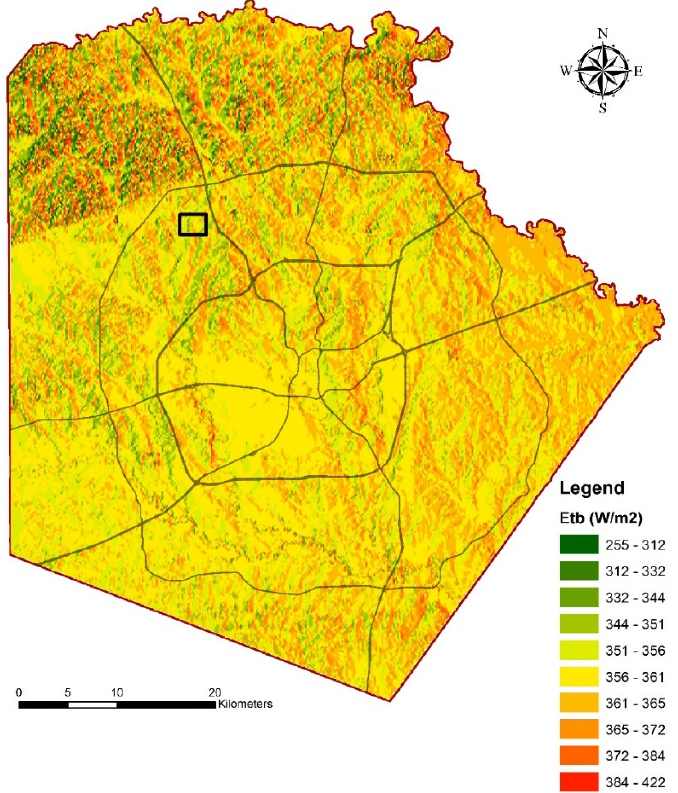
Figure 6. DEM-based solar map of San Antonio (Bexar County) on 21 July at 10:00 a.m., overlaying with major highways (black lines) of San Antonio and the neighborhood area (black rectangular box) for rooftop irradiance analysis (in Figures 7).